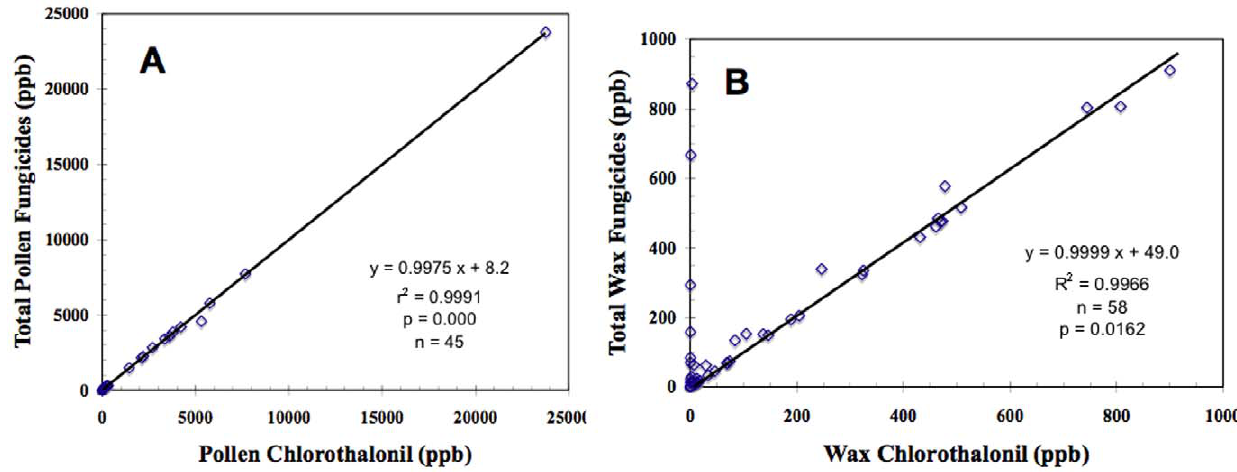
Figure 2. Correlations of pollen and wax chlorothalonil residues (ppb) with total fungicide contents in paired colony samples. Regressions of pollen chlorothalonil (A) and wax chlorothalonil (B) with total fungicides.